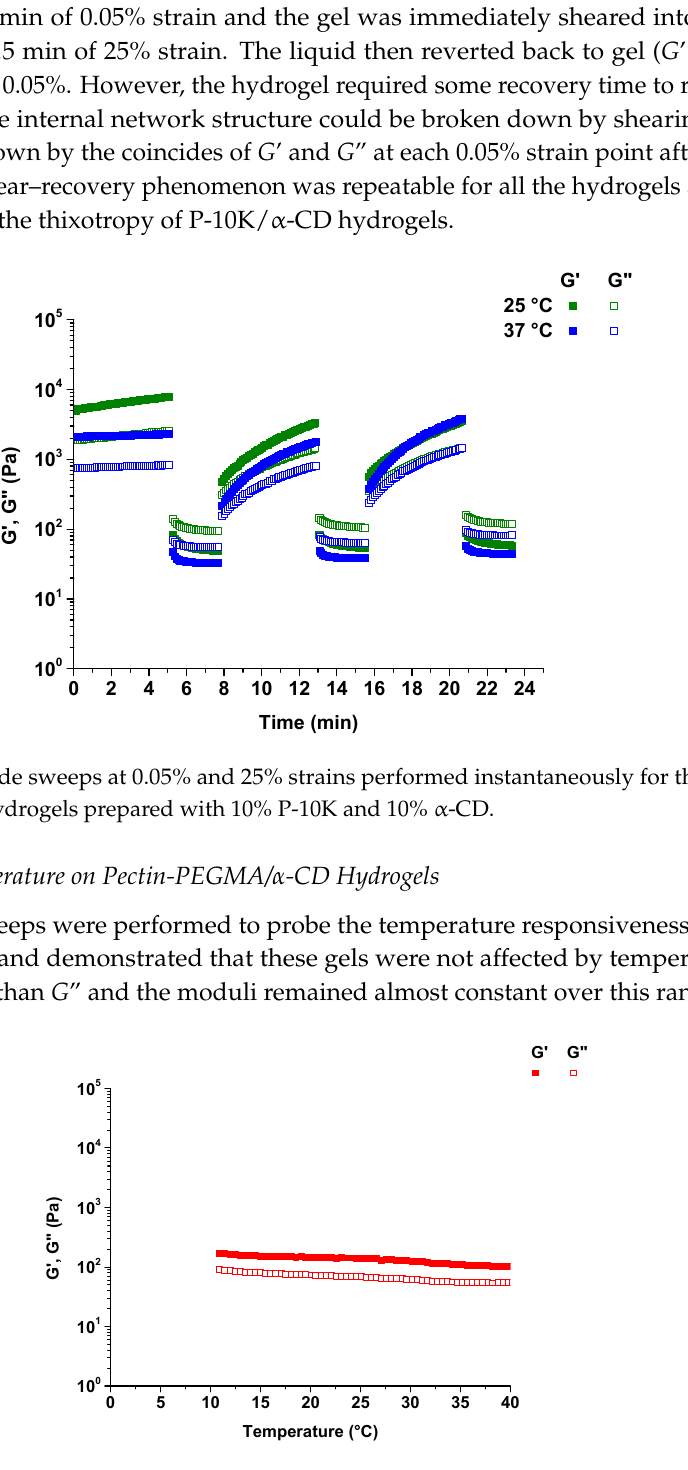
Figure 9. Temperature sweep performed from 10 to 40 °C on hydrogel prepared with 10% P-10K and 10% α -CD.